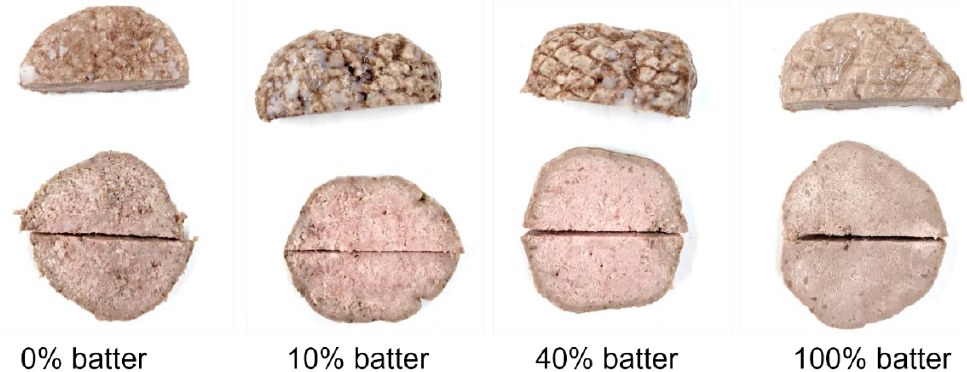
Figure 1. Example pictures of the cooked patty-style samples with increasing amount of BLS shown from the outside (upper row) and inside (lower row); from left to right: 0, 10, 40, 100% BLS.